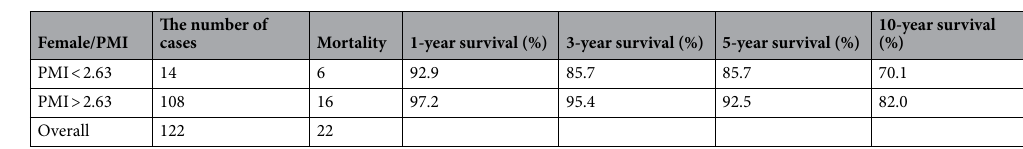
Table 3. Comparison of overall survival rate between sarcopenia and non-sarcopenia female patients.